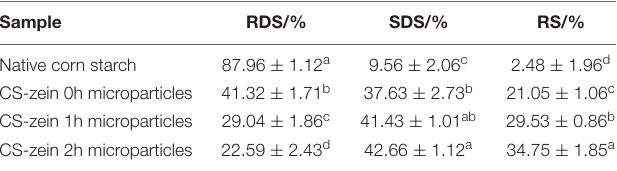
TABLE 5 | In vitro digestibility of native corn starch and core-shell starch/zein microparticles crosslinked by TGase for different times (0, 1, and 2 h).